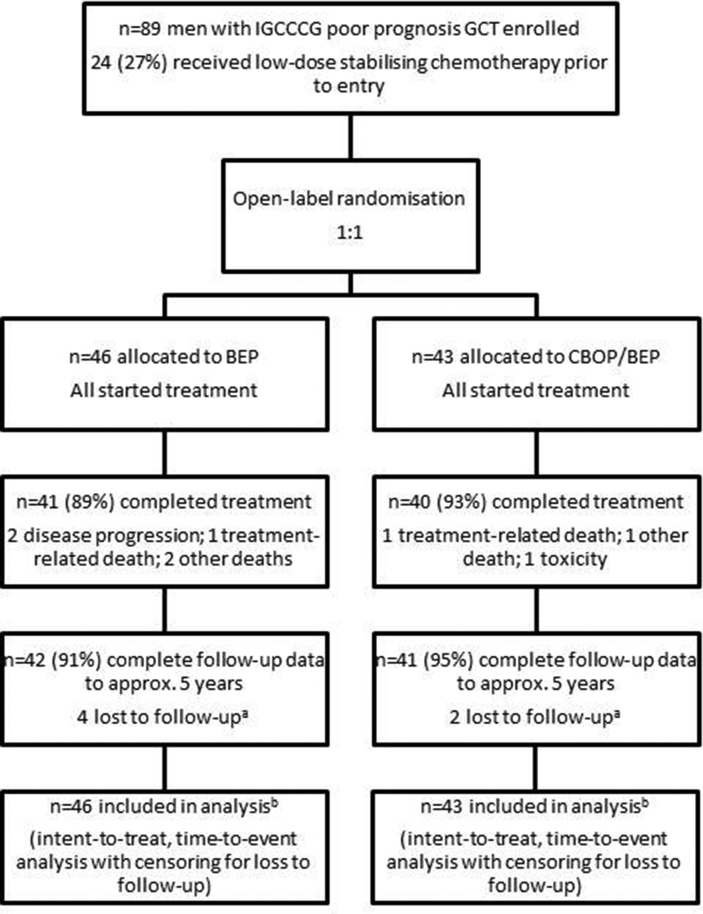
Flow of participants through the trial. a 2 of these patients had already had a progression event at the time of loss to follow-up (1 BEP and 1 CBOP/BEP, with 38 and 9 month postprogression follow-up, respectively) and so contribute complete data to the PFS analysis; in addition, survival information at ≥5 years was obtained from GPs for the 2 patients who had already progressed and a further 1 BEP patient. b 3 patients (2 BEP, 1 CBOP/BEP) are excluded from models incorporating marker decline because they only received one cycle of treatment in the trial and, therefore, did not have the relevant marker assessment for calculation of time to normalisation. In addition, analyses of 12-month toxicity are restricted to surviving patients (33 BEP, 32 CBOP/BEP) with follow-up assessment data between 10 and 14 months after randomisation.